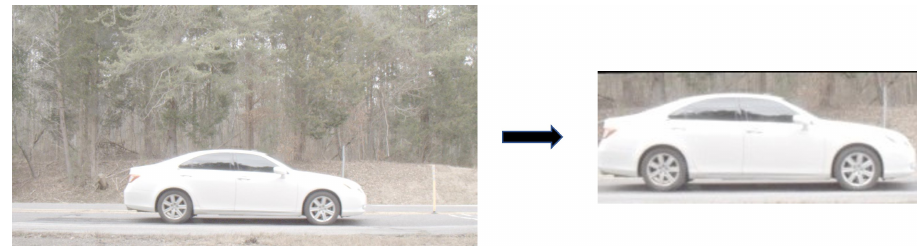
Figure 3. Before and after vehicle